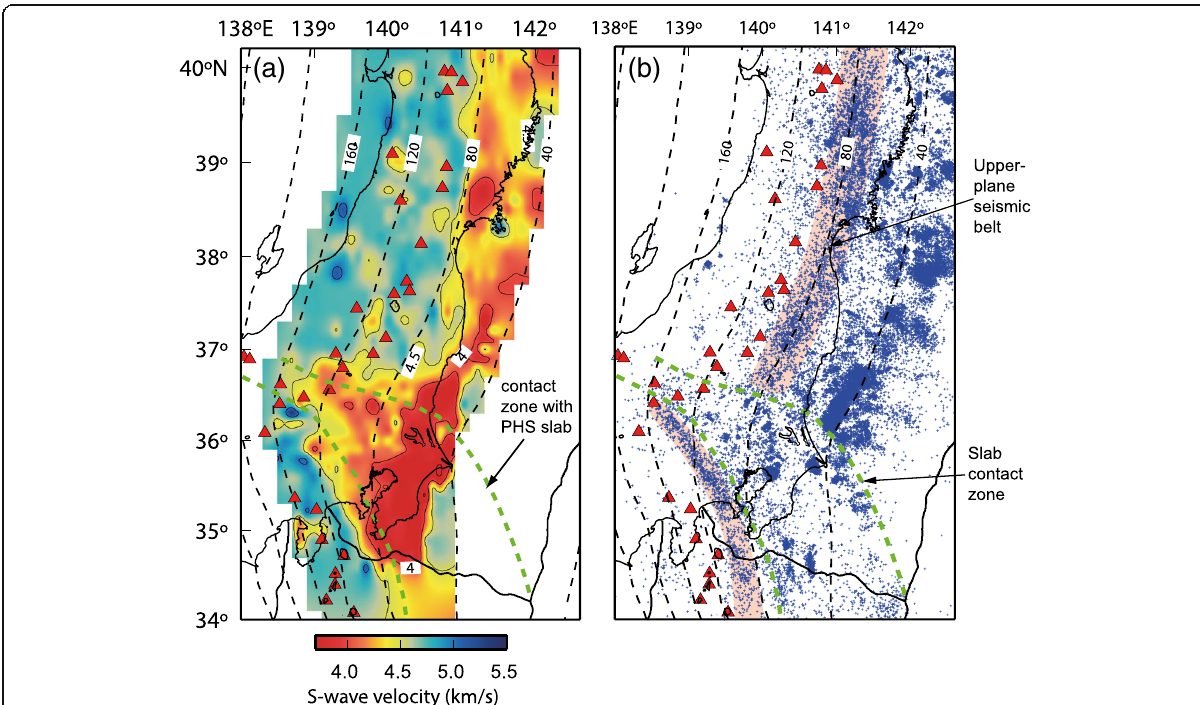
Fig. 10 Seismicity and S-wave velocity in the crust of the Pacific slab. a S-wave velocity distribution in the crust of the Pacific slab under NE Japan on a curved plane 5 km below the upper plate surface. b Hypocenters of earthquakes within the crust of the Pacific slab. Events 0 – 10 km below the upper plate surface are shown as blue dots , and the upper-plane seismic belt is shown in pink. Broken black curves denote iso-depth contours of the upper plate surface. The slab – slab contact zone is enclosed by two green broken curves. Red triangles are active volcanoes. (After Nakajima et al.